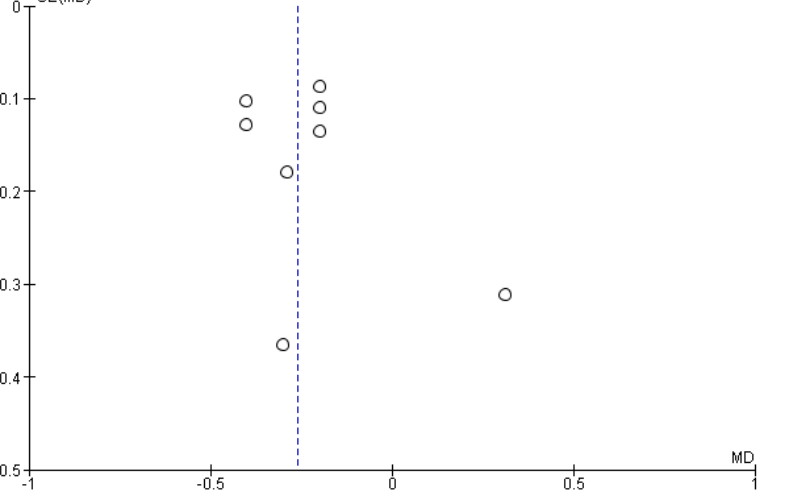
Figure 4. Funnel plot for the meta-analysis of probing depth (in mm) after three months of treatment with with either antibiotics or placebo among adult chronic periodontitis either antibiotics or placebo among adult chronic periodontitis patients.